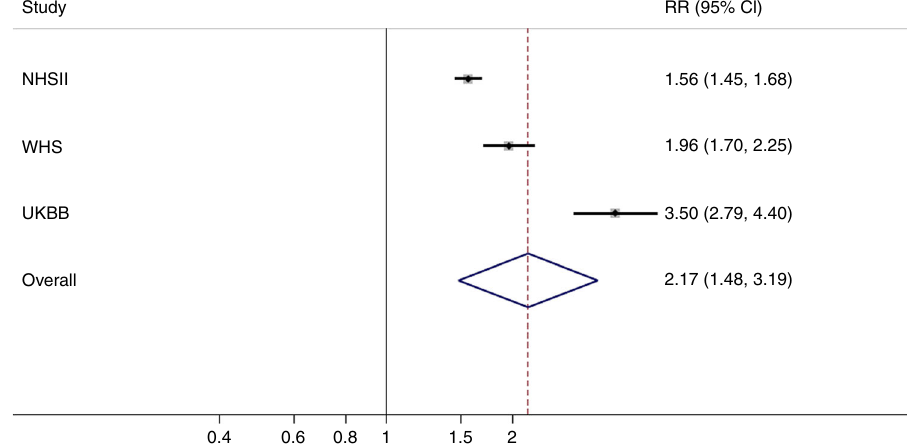
Fig. 4 Epidemiologic meta-analysis demonstrates endometriosis is associated with UL. Random-effects, inverse-variance-weighted meta-analysis was performed across the effect sizes and standard errors in 402,868 women from three cohorts (NHSII, WHS, and UKBB). Squares represent point estimates from individual studies, whiskers correspond to the 95% CIs, and the diamond represents results from the meta-analysis. There was evidence of signi fi cant heterogeneity based on Cochran ’ s Q statistic ( P < 1 × 10 − 4